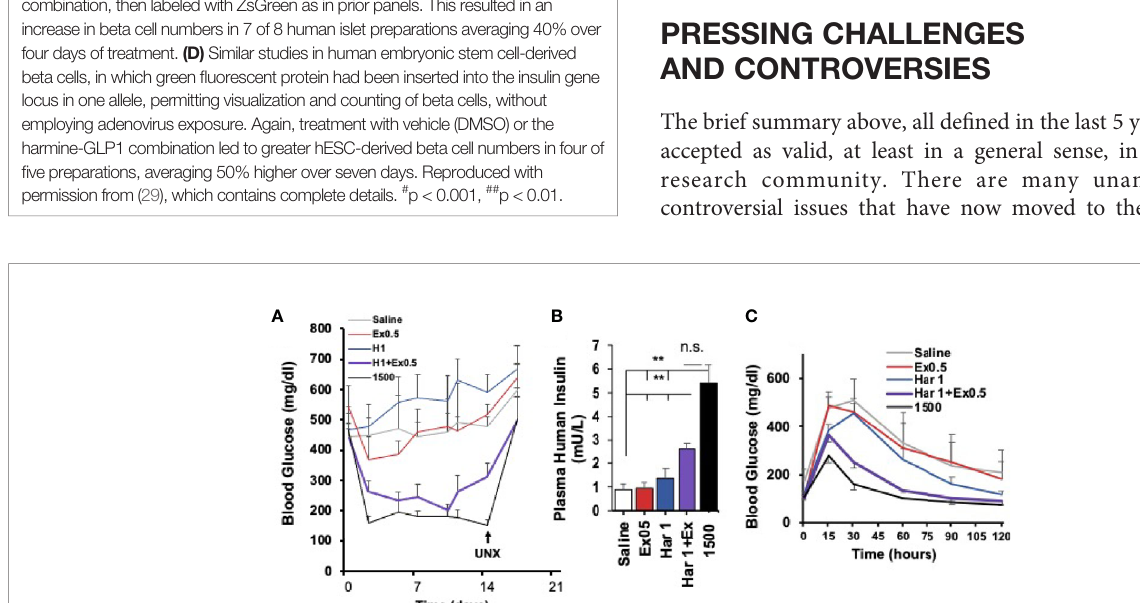
FIGURE 6 | Quanti fi cationofChangesinActualHumanBetaCellNumbersby FlowCytometry. (A – C) Humanisletcellsweredispersed,beta cellslabeledwithan adenovirusexpressingthebrightgreen fl uorescentprotein, ZsGreen,under the controloftheratinsulin-1promoter, followedby fl owcytometryto quantifygreen cells (28). (A) Representsanegativecontrol:progressivelydecreasingnumbersof humanislets werelabeled,thencountedby fl owcytometry. As expected, asfewer humanislets werelabeled,fewer betacellswere counted, inadose-relatedmanner. (B) Showsasecondnegativecontrol:humanisletswerelabeledwithRIP1-ZsGreen adenovirus,andtreatedwithvehicleorcytokines(IL-1 b ,TNF a ) thatinducehuman betacelldeath.Again,asexpected, reducednumbersofbetacells werecounted. In (C) ,humanisletsweretreatedwithvehicle(DMSO)or theharmine-GLP1 combination, thenlabeledwithZsGreenasinpriorpanels. Thisresultedinan